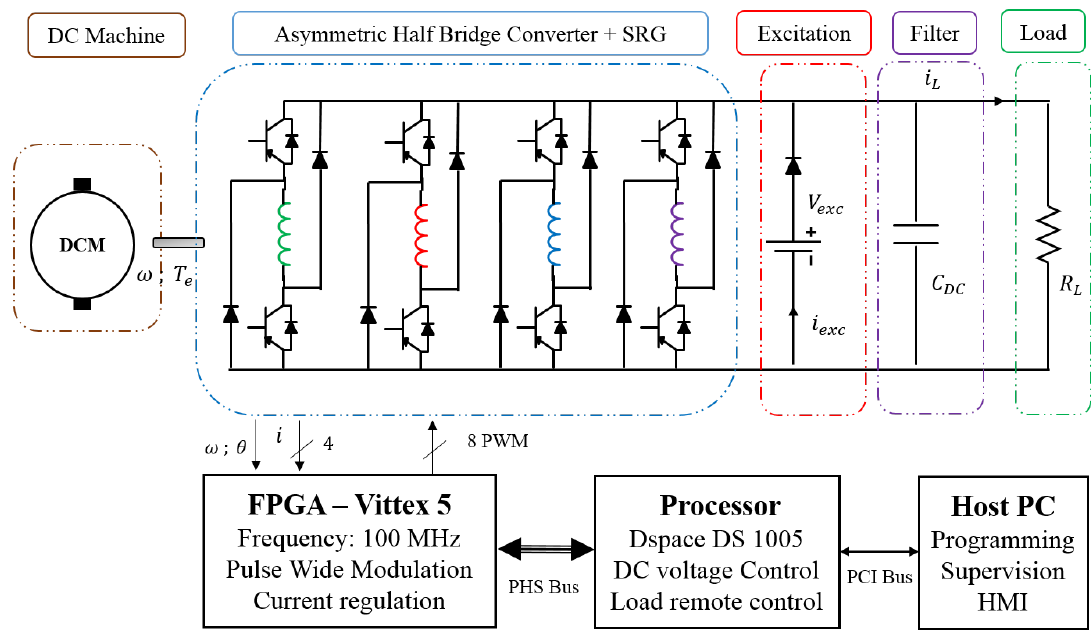
Figure 2. Electrical layout of power